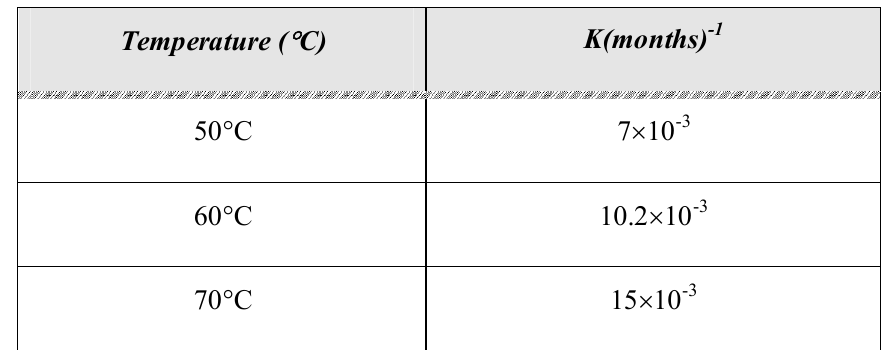
Table (6): A comparison between the effect of method of incorporation of disintegrant extra and intra.